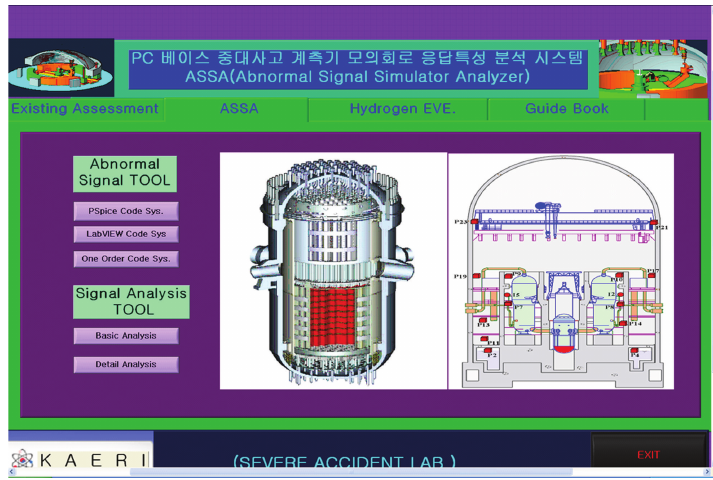
Figure 2: Initial screen consisting of functions for ASSA